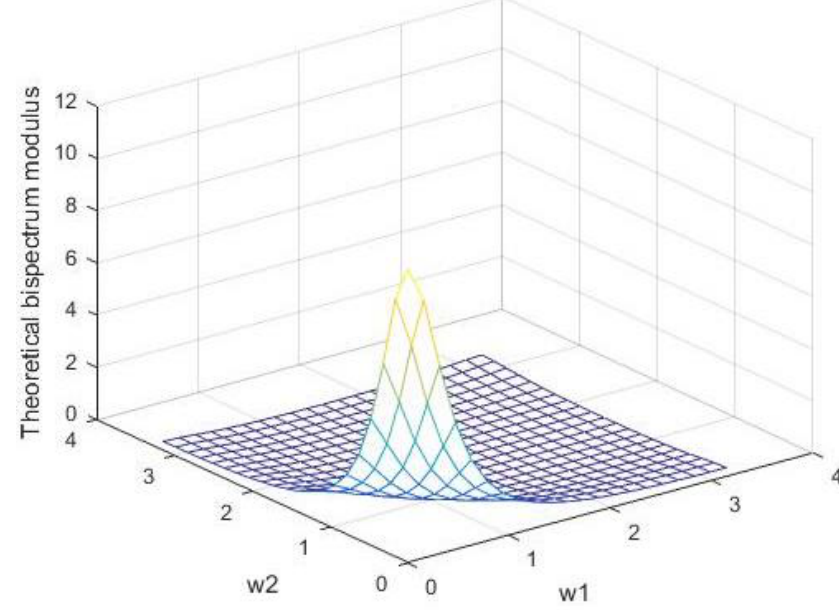
Figure 4. The theoretical bispectral modulus of the